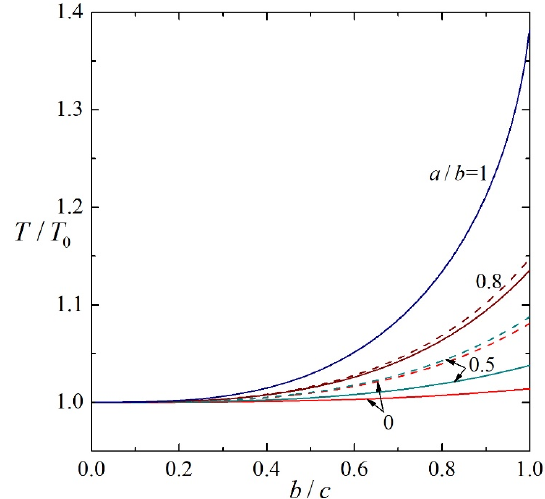
Figure 6. Normalized torque T / T 0 for a soft sphere rotating about a diameter perpendicular to two planar walls vs. the shielding parameter λ b with b / c = 9/10. The solid and dashed curves denote cases of c / ( c + d ) = 1/2 and c / ( c + d ) = 0, respectively.